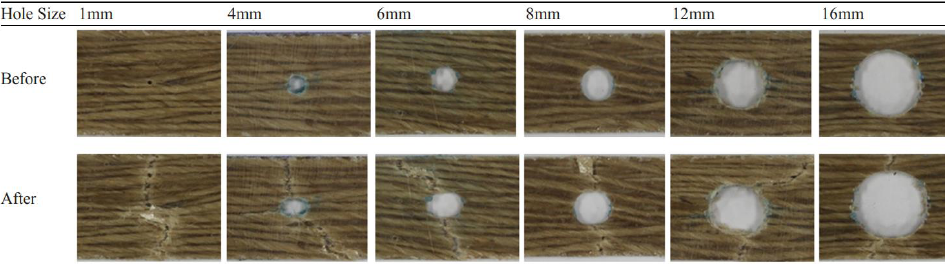
Figure 5. Front view of specimens with holes of different diameter before and after tensile test [76].